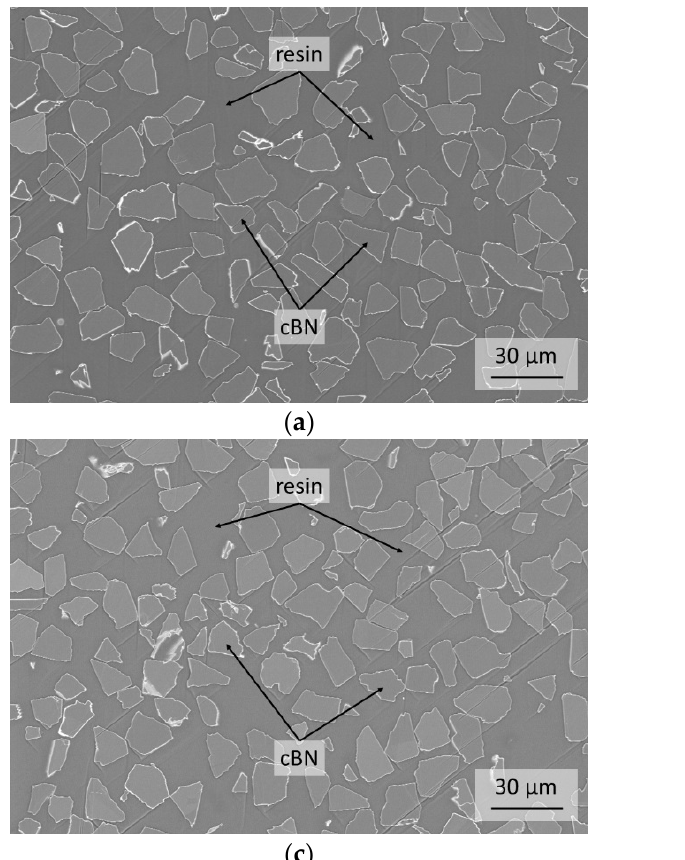
Table 2. Mass losses of the cBN-powders after thermogravimetric analysis under argon and nitrogen atmosphere up to a temperature of 1600 ◦ C. cBN-Powder Coating Atmosphere B21 -